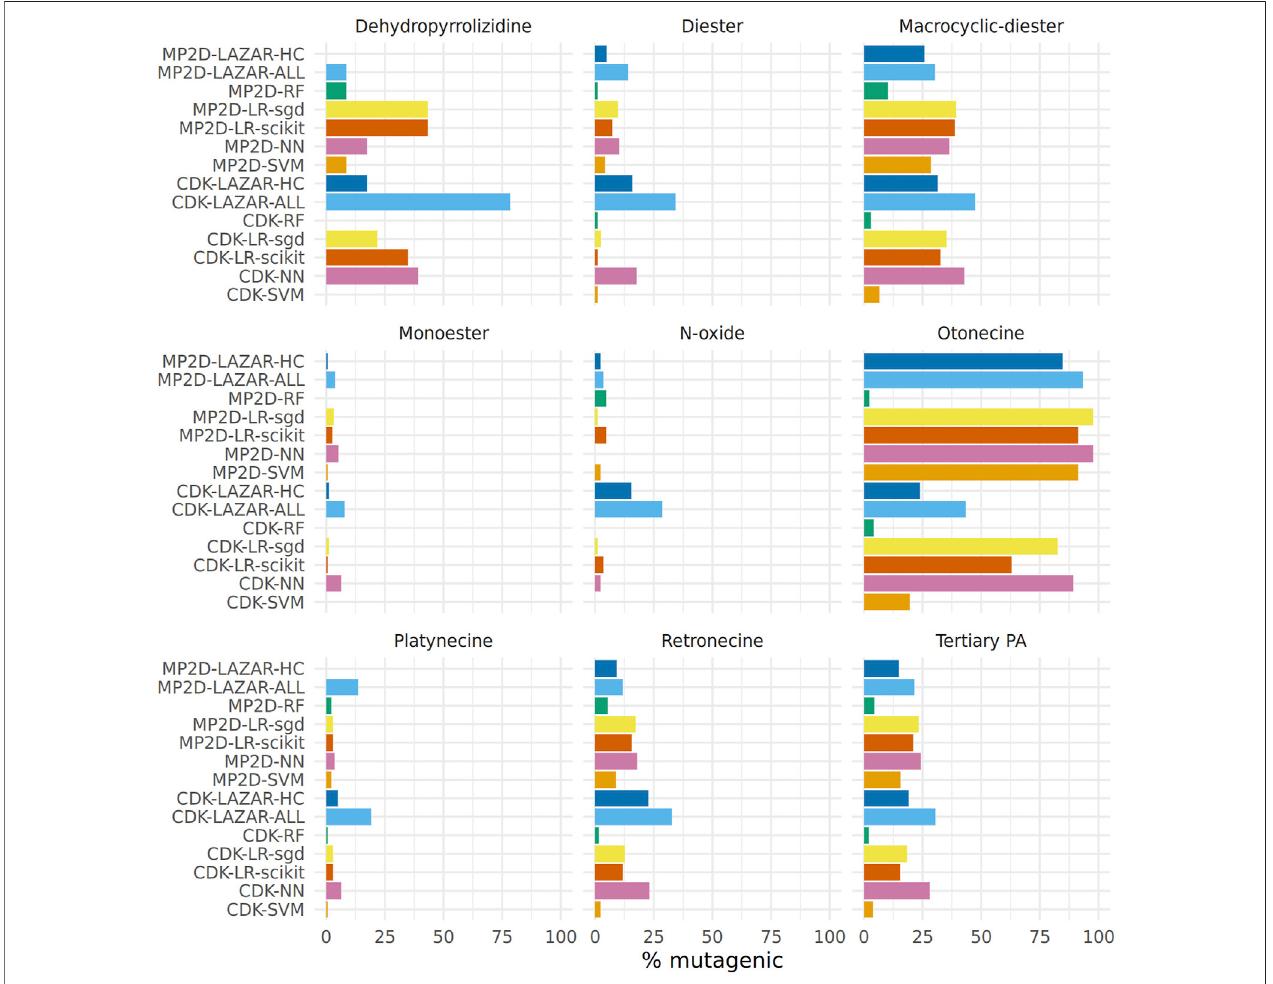
FIGURE 7 | Summary of pyrrolizidine alkaloid predictions.